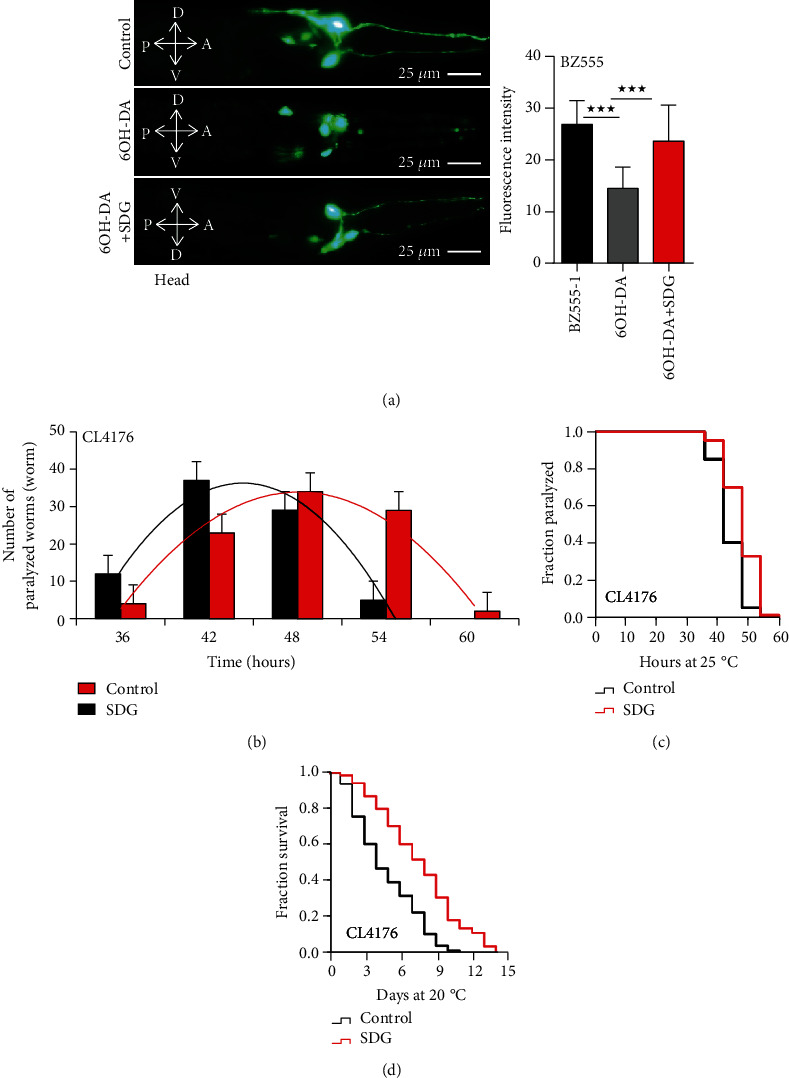
SDG protects DA neurons from 6-OHDA-induced neurodegeneration and decreases Aβ-induced toxicity in C. elegans. (a) The result of dopaminergic neurodegeneration assay. Worms were observed and photographed using a fluorescent microscope (Leica DM6B) with appropriate filter sets for GFP (magnification: 400x). SDG improved the shrinkage of neuronal cell bodies caused by 6-OHDA. The fluorescent intensity of DAT-1::GFP at neuronal dendrite was decreased due to 6-OHDA in BZ555 mutant, which was improved with SDG treatment significantly; p < 0.0001. (b, c) The results of paralysis assays using CL4176 strain treated with or without 500 μM of SDG. The number of worms paralyzed every six hours was fitted by normal distribution curves to indicate the peak period of paralysis, while Kaplan-Meier survival curves showed the onset of paralysis of CL4176 strain. SDG significantly delayed the onset of paralysis of the CL4176 strain caused by Aβ-induced toxicity at 25°C (p < 0.0001, log-rank test). (d) The mean lifespan of CL4176 strain treated with or without 500 μM of SDG at 25°C. SDG extended the lifespan of CL4176 by up to 57.0% (p < 0.0001, log-rank test). A statistically significant p value was calculated by the t-test or log-rank test; ★★★p < 0.0001. The results from three repeated experiments and the statistical details are summarized in supplementary Tables S5, S7, and S9.